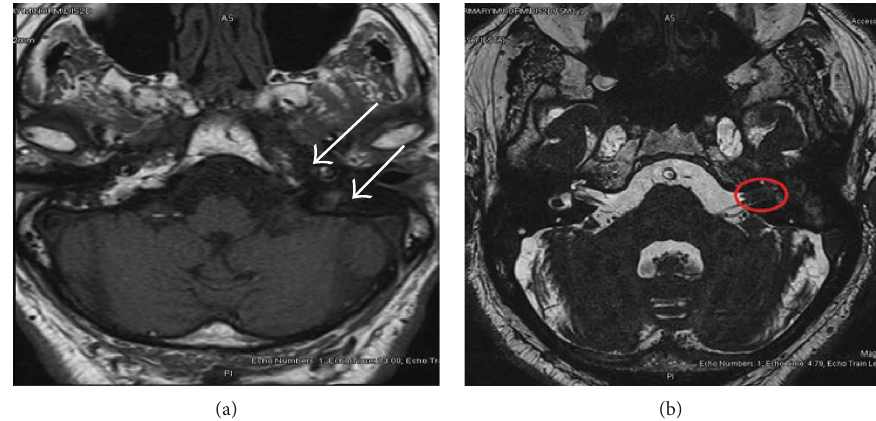
Figure 2: (a) MRI with contrast showing asymmetrical signal changes in the bilateral petrous bone with reduced enhancement on the left with high suspicion of petrositis. (b) Contrast showing an enhancing lesion in the internal auditory meatus involving the 7th-8th nerve complex most likely acoustic neuroma (red